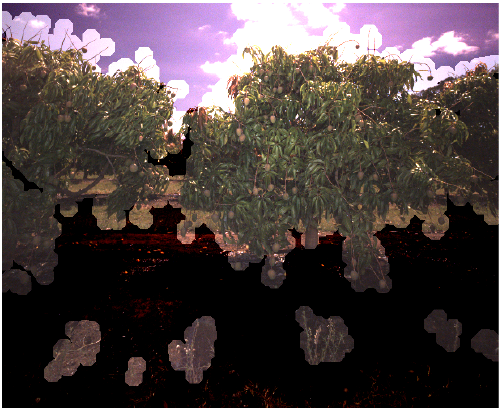
Figure 21. A false track association causes the identity of two mangoes to swap. In ( a ), two fruit are detected and assigned ids. In ( b ), the same two fruit are detected along with a third that is correctly assigned a new id. The corresponding projections are shown in ( c ). The ids of the two fruits have incorrectly swapped due to the similar distances to the epipolar projections.